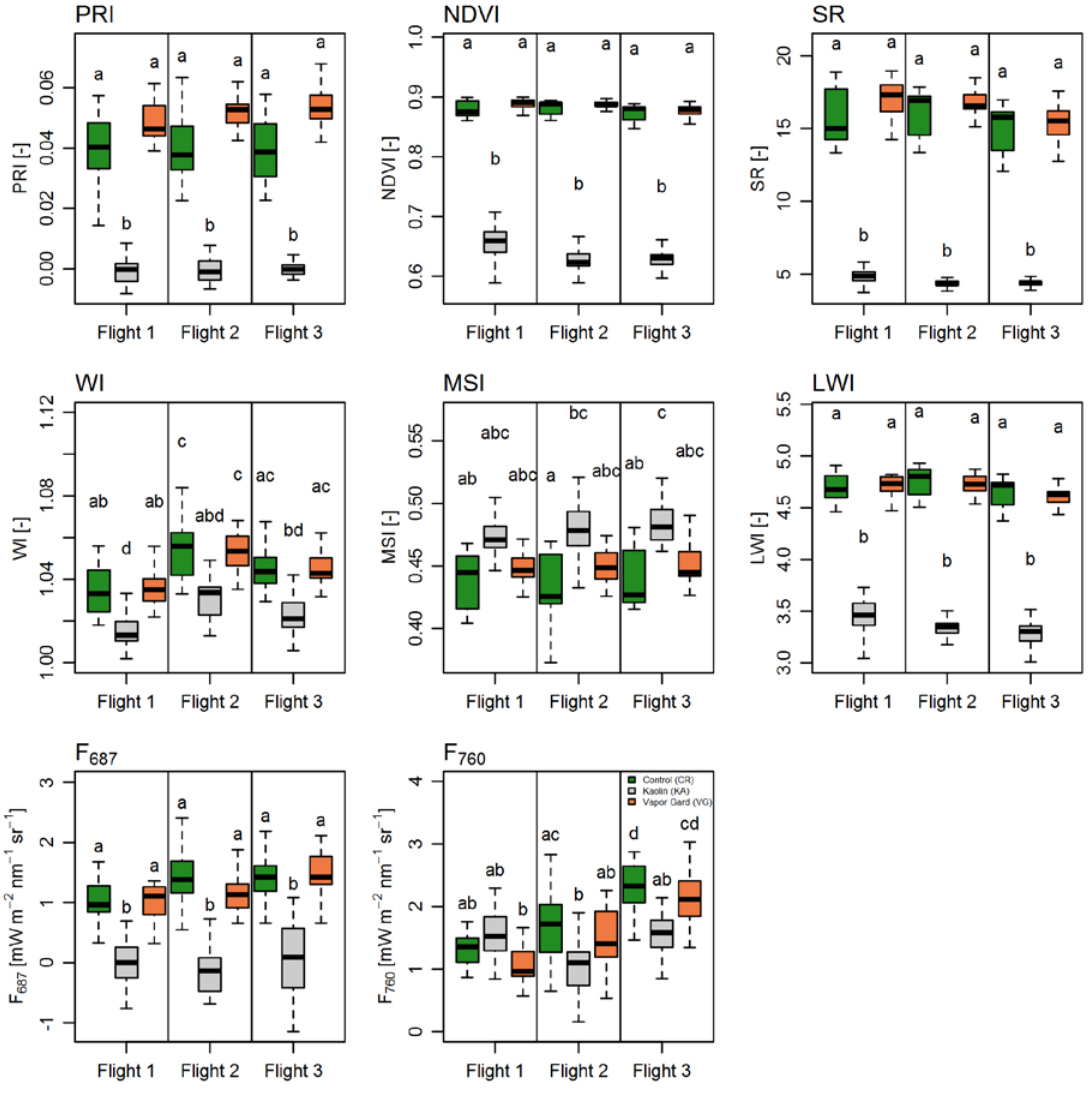
Figure 7. Boxplots of the different treatments (CR, KA, and VG) at three HyPlant overpasses for VNIR/SWIR based indices and F 687 and F 760 . Different letters indicate significant differences ( * p ≤ 0.0 5).